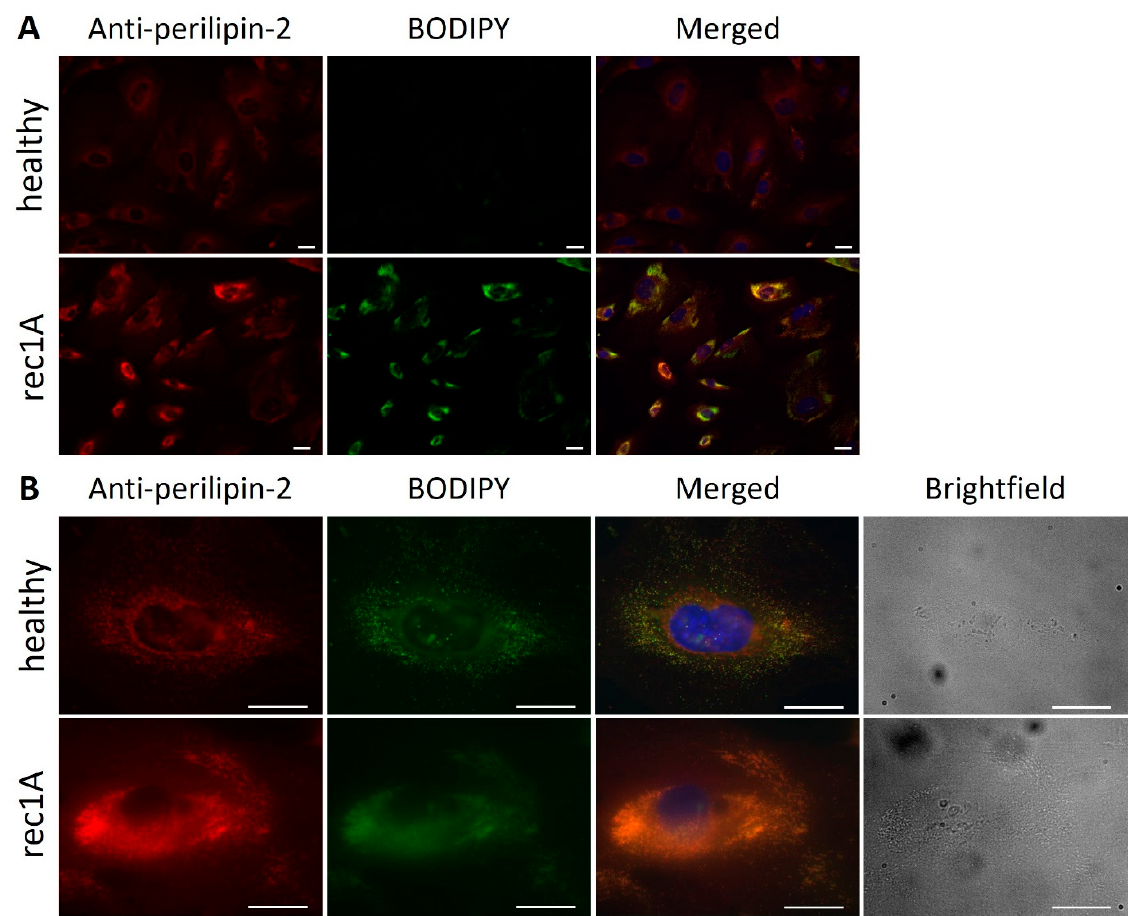
Figure 7. Expression of perilipin-2 and lipid droplets colocalize and are increased in hPod exposed to FSGS plasma. Fluorescence microscopy images of hPod differentiated in slide flasks (Thermo Fisher Scientific), exposed to active disease FSGS plasma rec1A or to healthy plasma, labeled with anti-perilipin-2 antibody and BODIPY. ( A ) Perilipin-2 and BODIPY fluorescence intensities were increased in hPod exposed to rec1A plasma compared to healthy plasma. ( B ) Zoom in to visualize colocalization (yellow) and an increase in number and size of lipid droplets in cells treated with rec1A plasma. Double staining was validated by fluorophore omission experiments demonstrating that staining intensities are not affected by combining both fluorophores (Supplementary Figure S2). Additional brightfield imaging showed increased granularity in hPod exposed to rec1A plasma compared to healthy plasma. Red: perilipin-2; green: BODIPY; Blue: DAPI. Scale bar: 50 µm. healthy: pooled plasma from five healthy donors; rec: patient with recurrent FSGS.